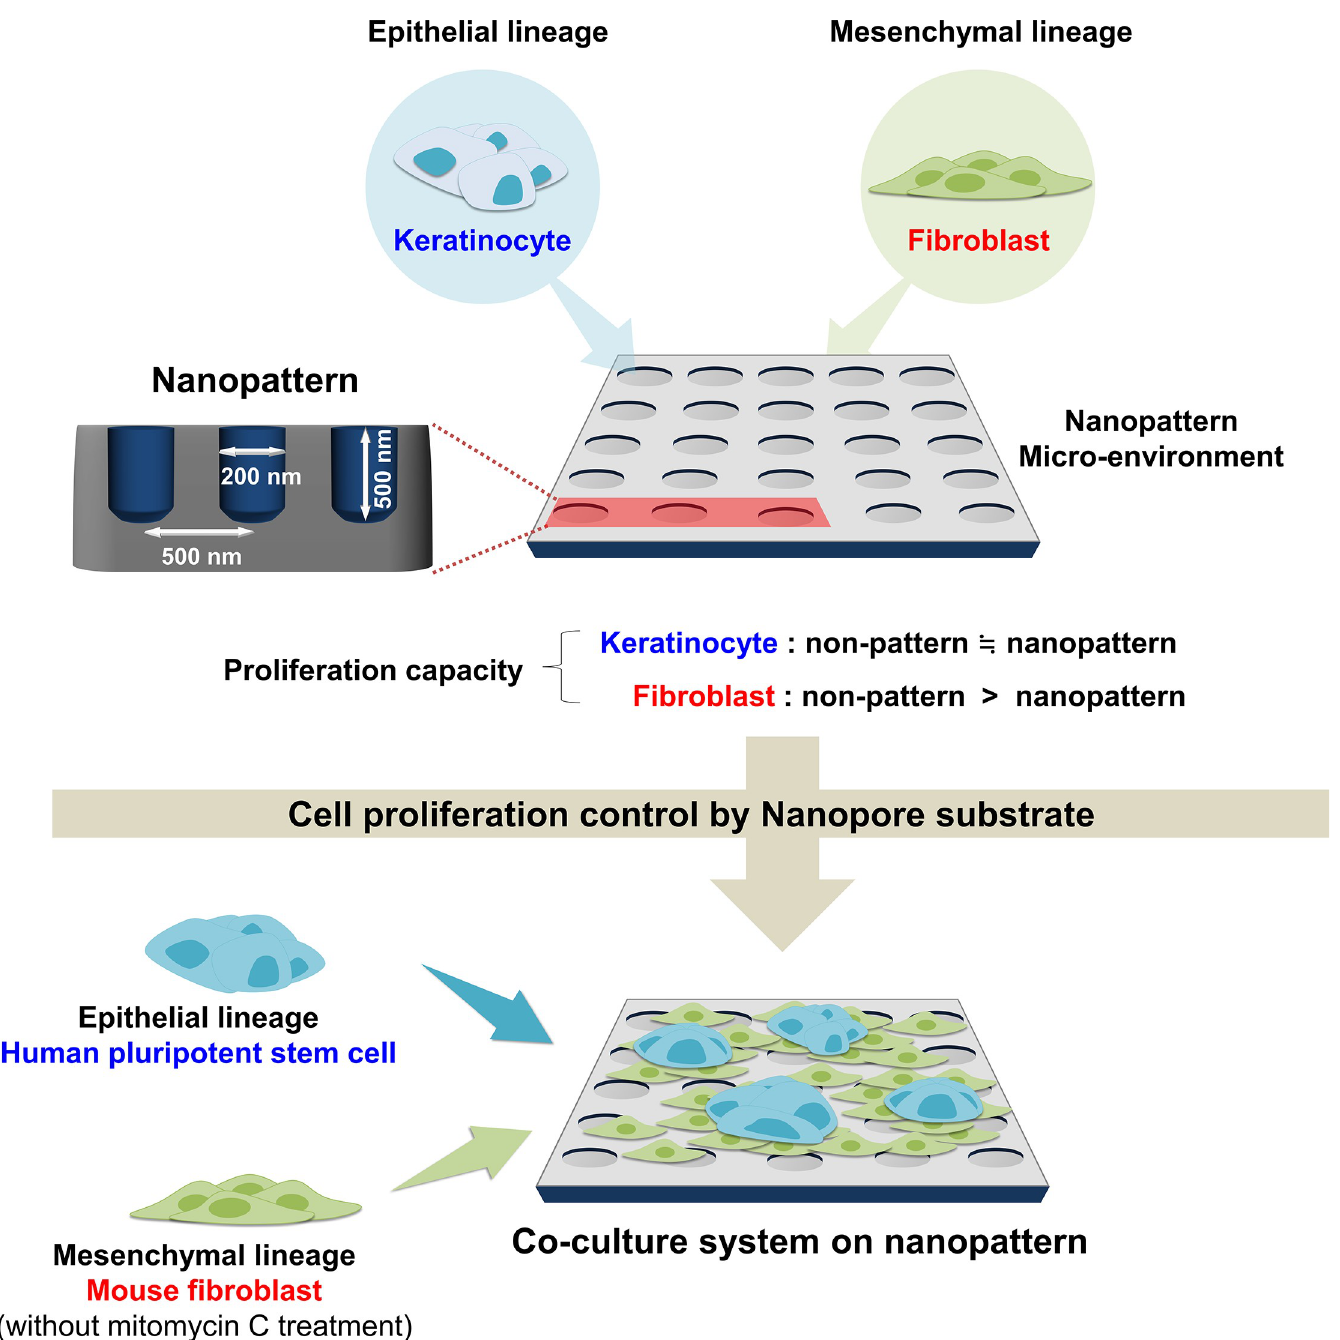
Fig 5. Schematic diagram of a new coculture system strategy using nanopatterns. epithelial type cells. Fig 3D results show that the growth inhibited fibroblasts by MMC-treat- ment secrete the various growth factors such as VEGF, HDF, and DKK1, which induce differ- entiation of hPSCs. Also, hPSCs co-cultured with MMC-treated fibroblasts for more than 5 days could be observed to promote differentiation (S3 Fig). Therefore, depending on the